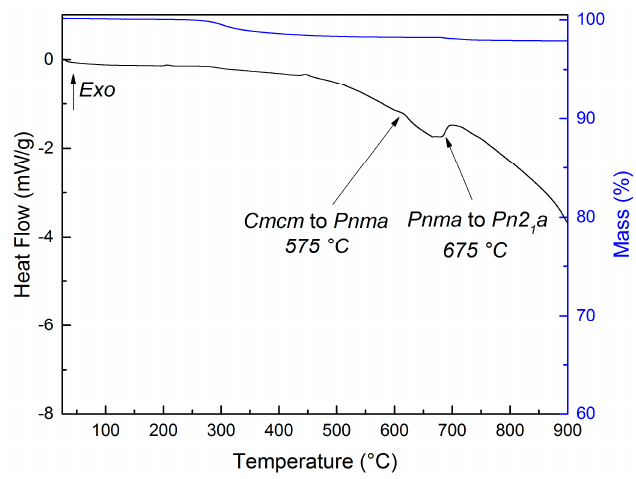
Figure 4. Thermal and gravimetric analyses for LCP- Cmcm (PO) obtained from the polyol route. TGA data are drawn in blue, and DSC data in black.